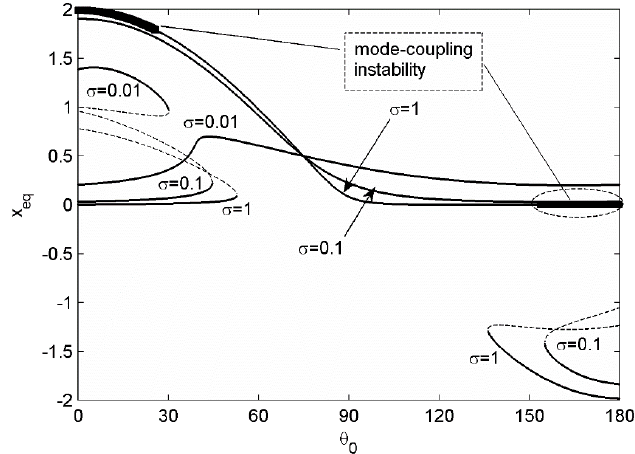
Figure 10. Steady-sliding equilibrium curve with respect to θ o at µ o = 0.5.